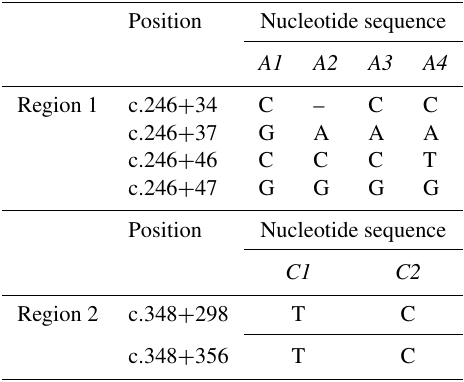
Table 2. Sequence variation in the two regions of ovine FABP4 . Position Nucleotide sequence A1 A2 A3 A4 Region 1 c.246 + 34 C –